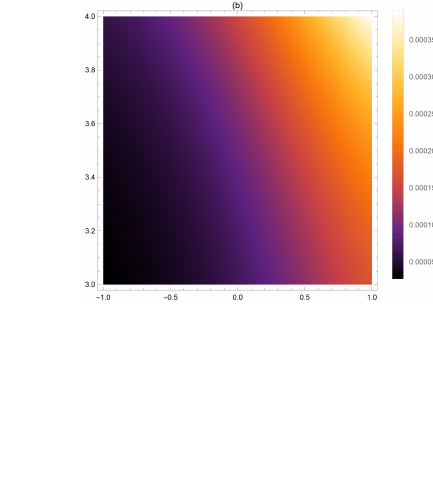
Figure 2. Solitary wave solution of Equation (16) in ( a ) three–dimension, ( b ) density and ( c ) spherical plot three–dimensional for h 1 = − 1, h 3 = 9, ϑ = 1, (cid:36) = 1.